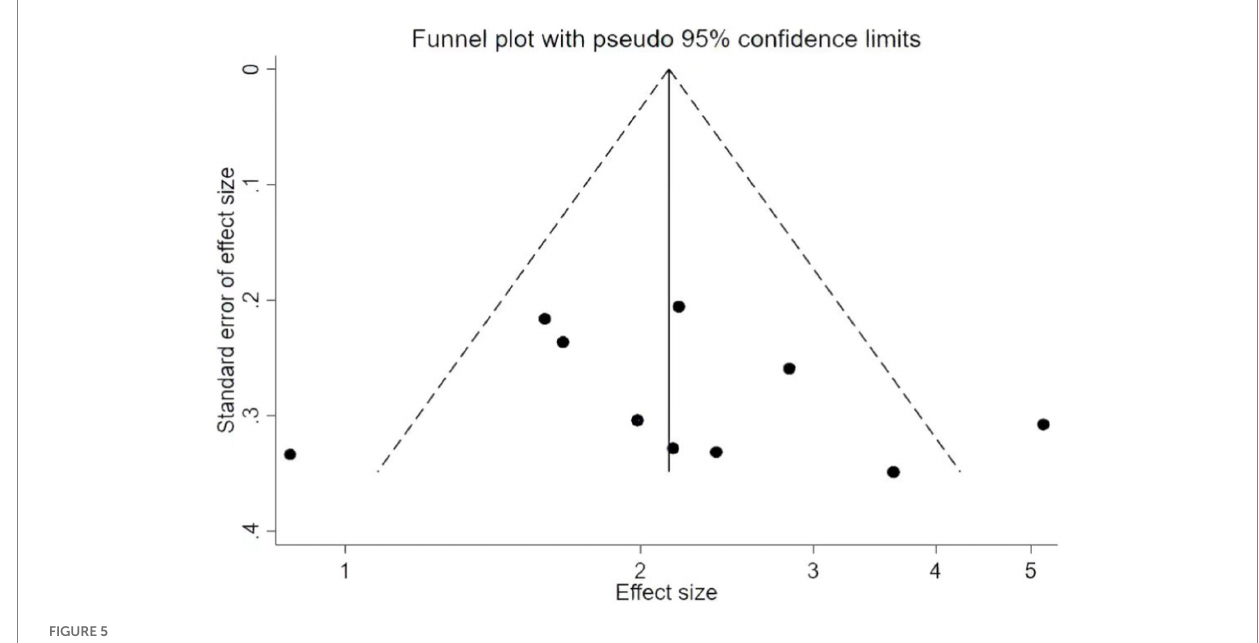
FIGURE 5 Publication bias of Montreal cognitive assessment